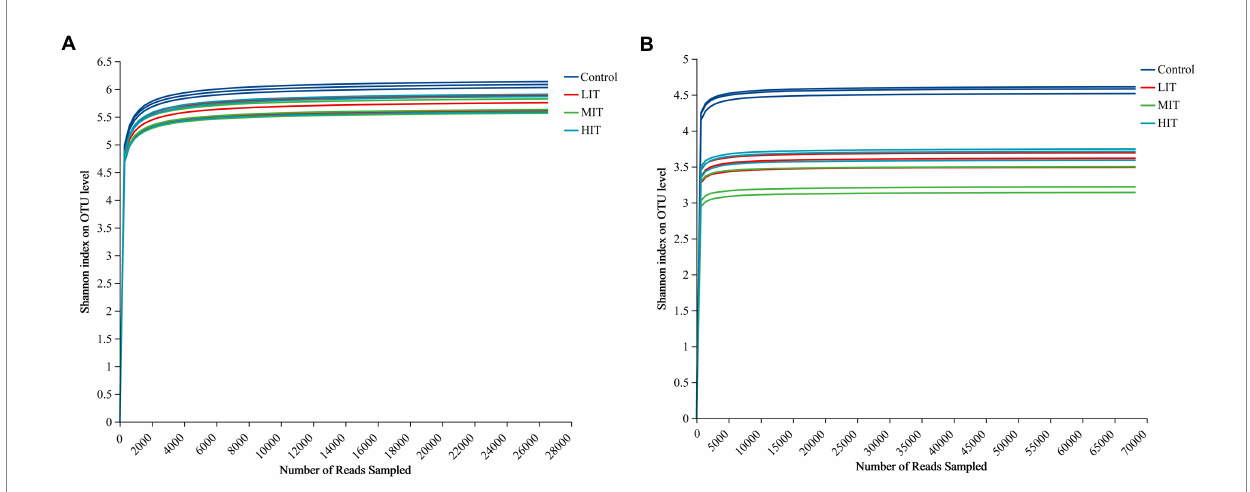
The values are the mean ± standard deviation ( n = 3), followed by different letters showing significant differences in the four thinning treatments for each index at the 0.05 probability level. SM, soil moisture; SBD, soil bulk density; SOM, soil organic matter content; TN, TP, TK, AN, AK and AP, contents of total nitrogen, total phosphorus, total potassium, available nitrogen, available potassium, and available phosphorus, respectively.